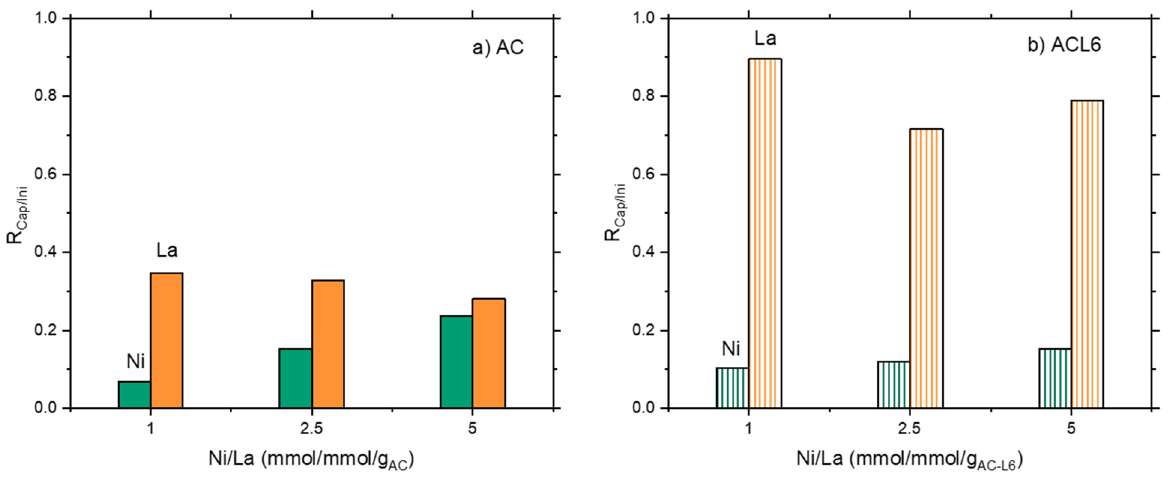
Figure 6. The ratio between metal capture and contacted metal as a function of Ni/La ratio in the initial solution: ( a ) unmodified AC and ( b ) modified ACL6.